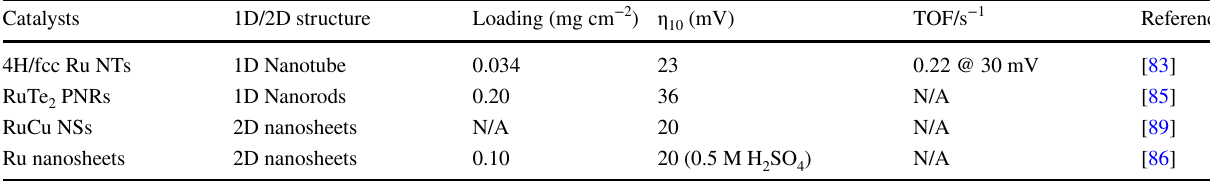
Table 4 HER performance in 1D/2D structure at 1.0 M KOH